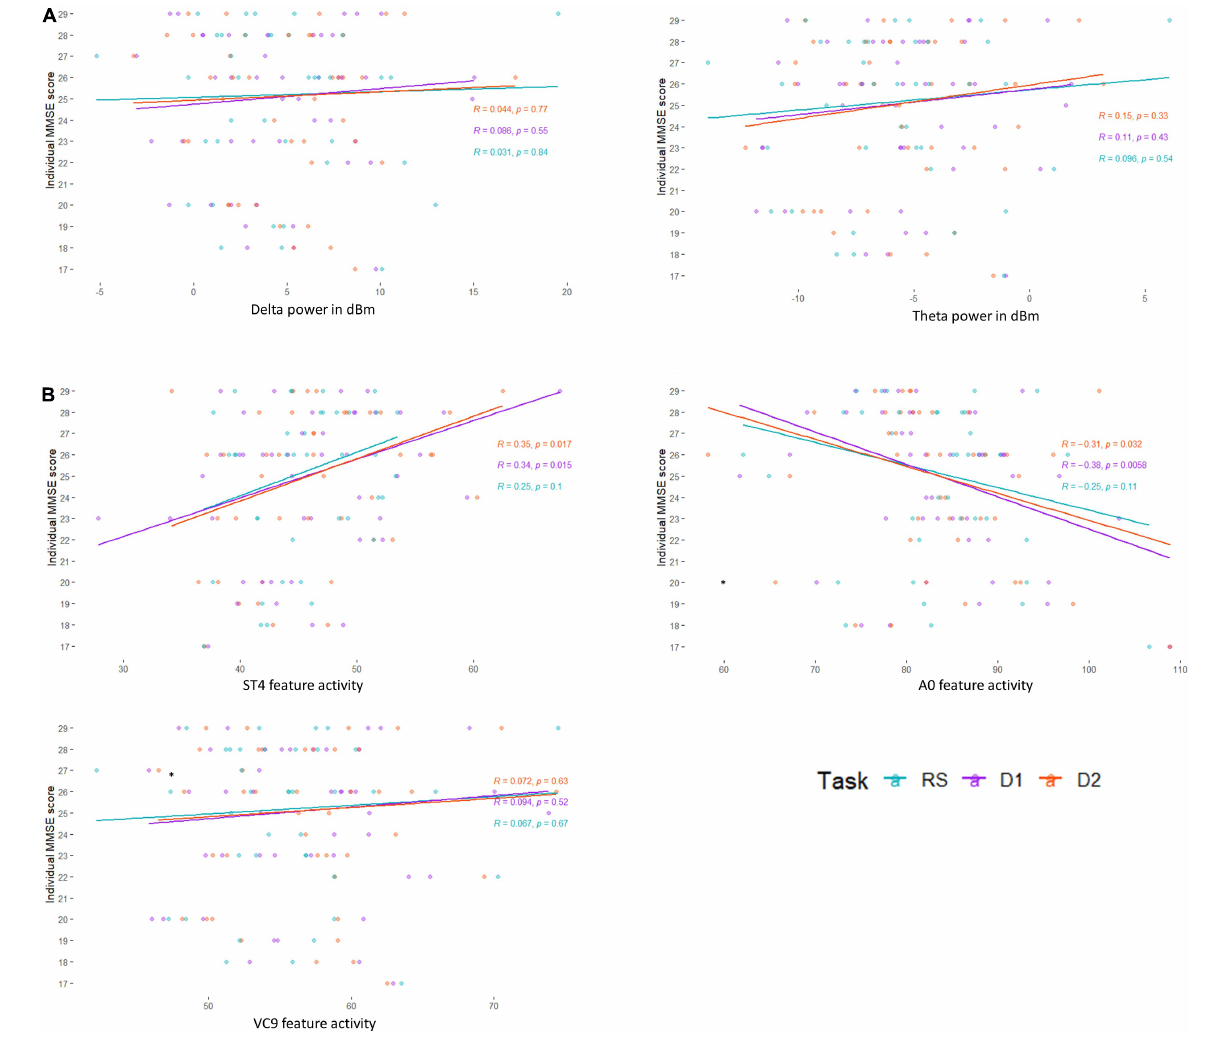
FIGURE 4 | Pearson correlation between individual MMSE scores and (A) EEG frequency bands Delta and Theta, and (B) EEG features A0, ST4, and VC9, as a function of task level: resting state (blue), detection level 1 (purple), and detection level 2